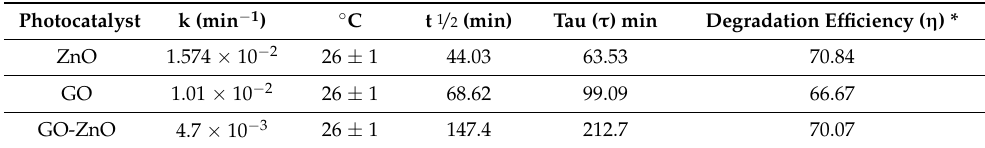
Figure 9. Graph of ( a ) Absorbance vs. UV-irradiation time (min), ( b ) ln(C/C o ) vs. UV irradiation Time (min). Table 2. The half-life, rate constant, degradation efficiency, and time constant of the catalyst were estimated experimentally.